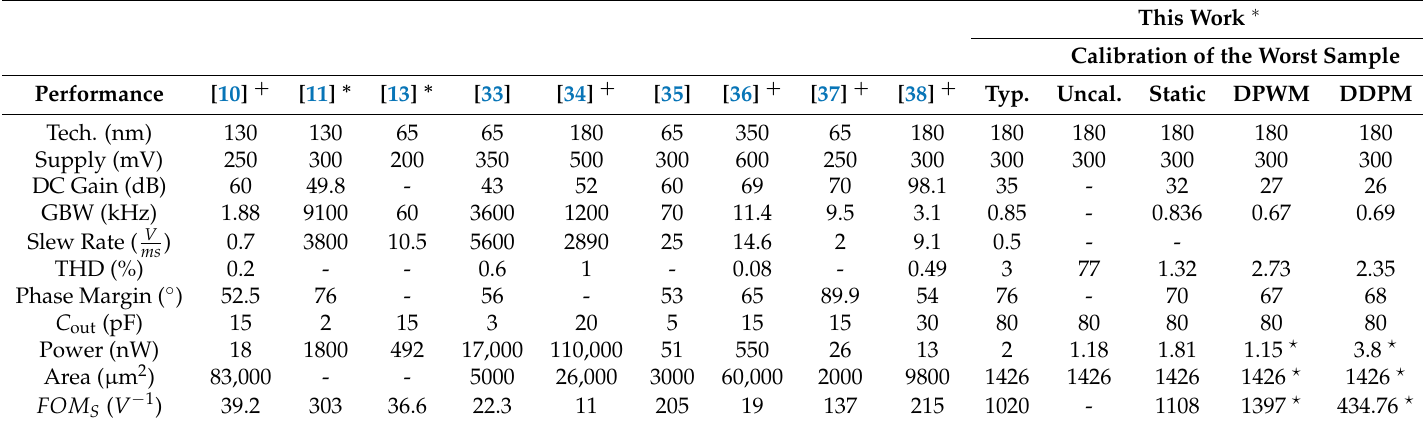
Table 2. Comparison with the state-of-the-art Ultra-Low-Voltage Operational Transconductance